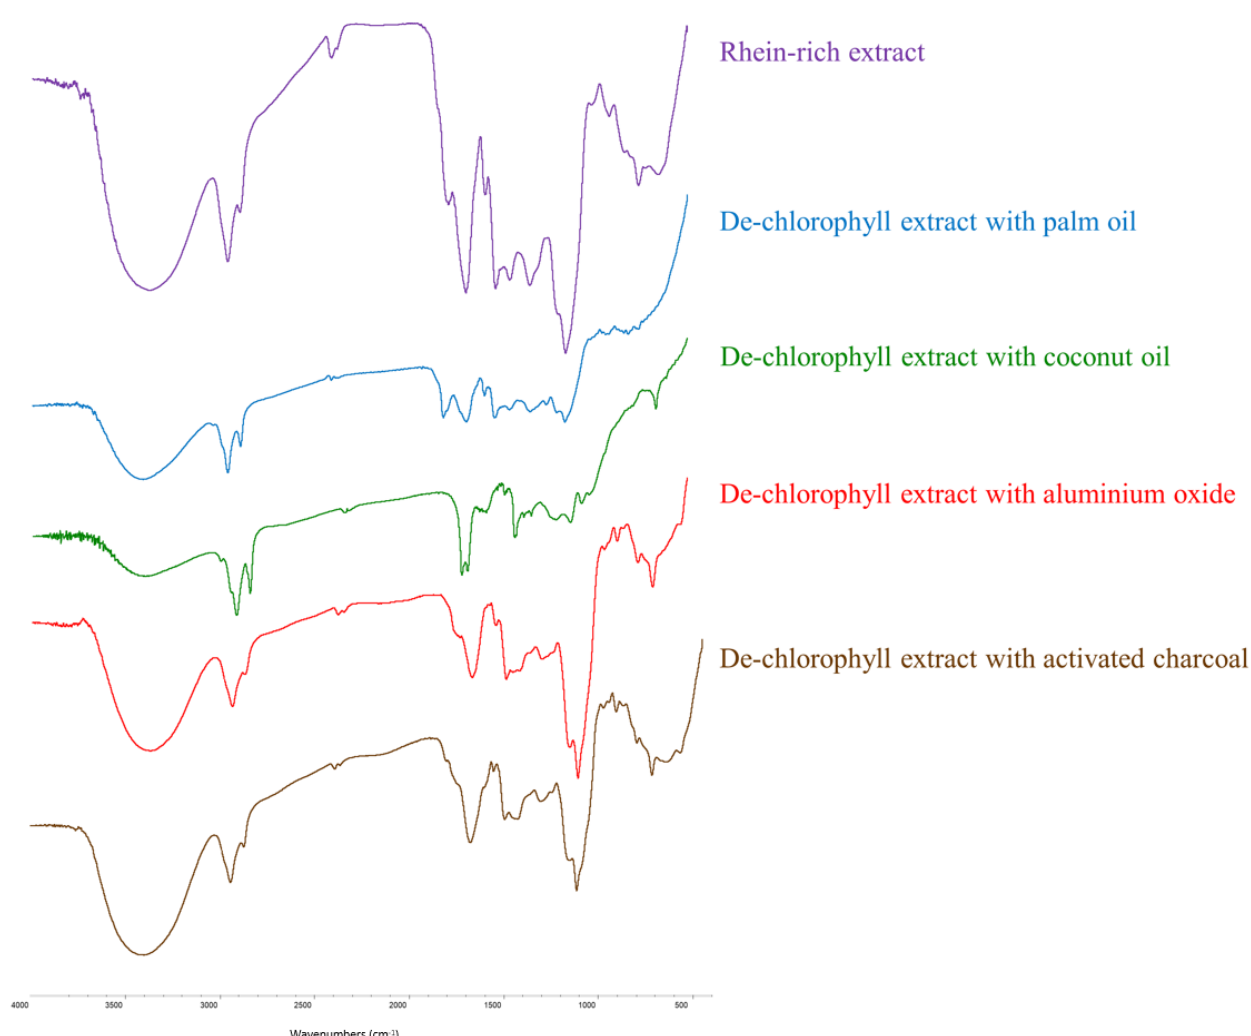
Figure 5. FTIR spectra of rhein-rich extract and its de-chlorophyll extracts with palm oil, coconut oil, aluminum oxide and activated charcoal.